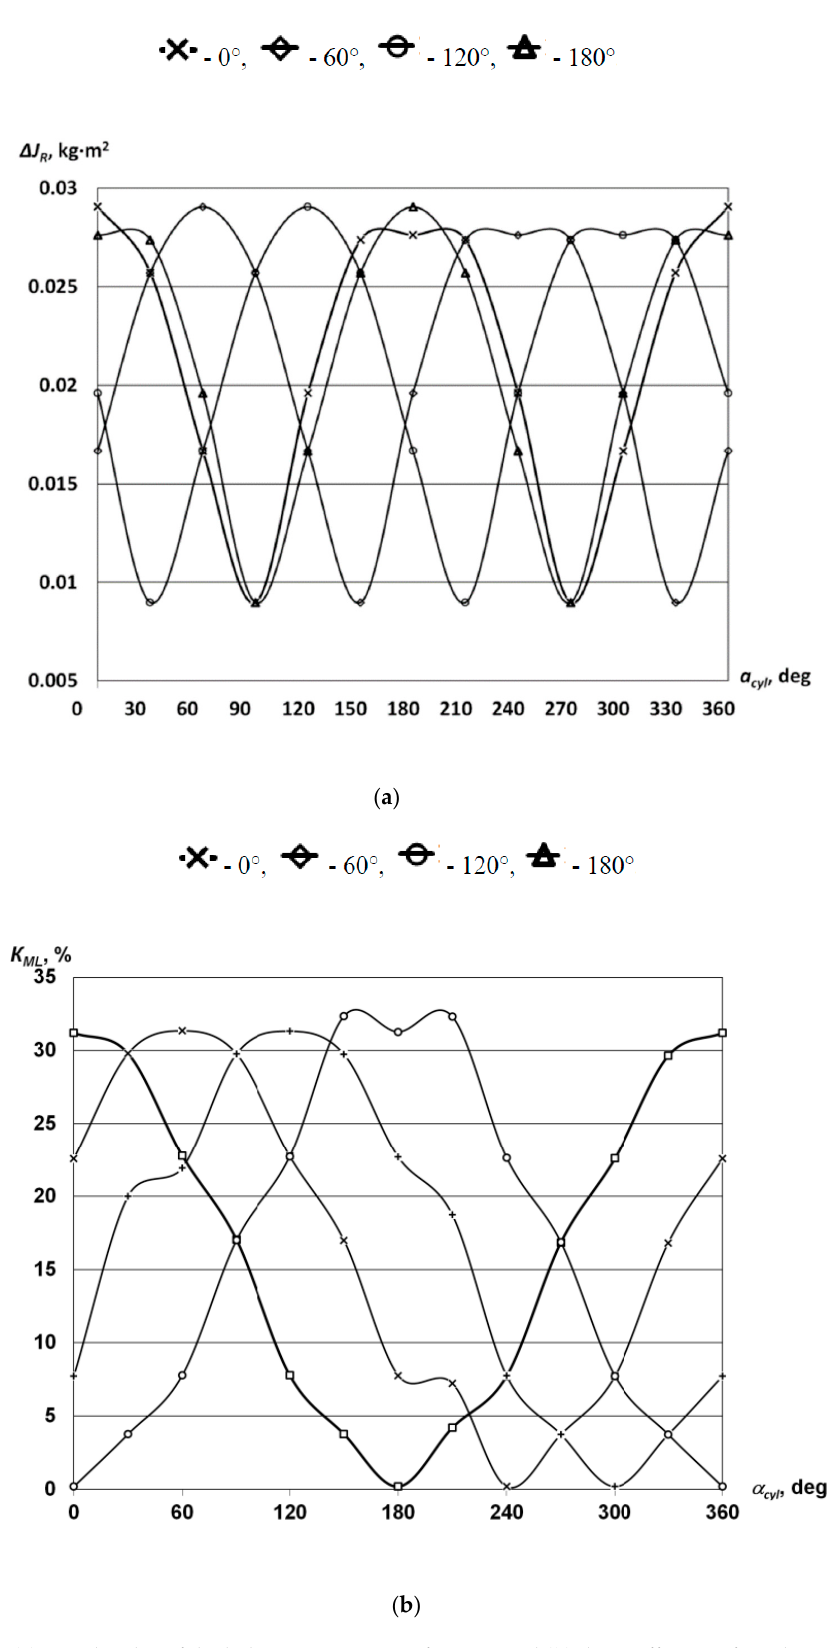
Figure 8. ( a ) Amplitudes of the balancing moment of inertia and ( b ) the coefficient of mechanical losses, with respect to 𝛼 (cid:3030)(cid:3052)(cid:3039) , for 0° ≤ 𝑎 (cid:3030)(cid:3045) ≤ 180° [26]. Figures are reprinted with permission from